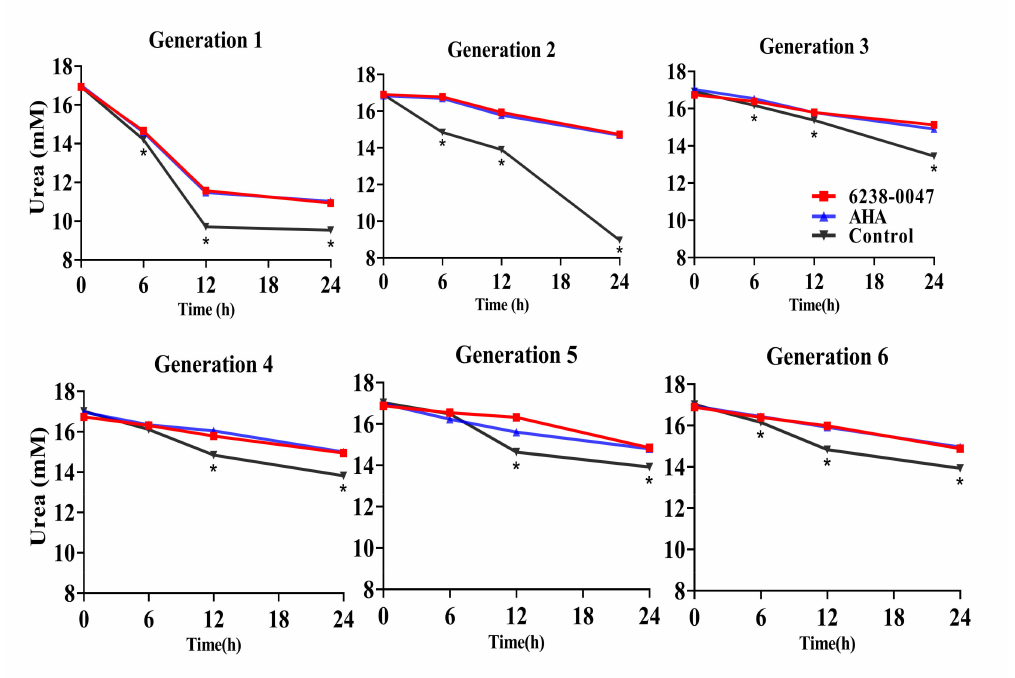
Figure 4. Influence of compound 6238-0047 on the urea in rumen fermentation in vitro. Each point represents the mean of three observations. Acetohydroxamic acid (AHA) acted as a positive control, and the control group only added the methanol solution. Asterisks (*) indicate that the di ff erence between the control group and compound treated group (AHA and 6238-0047) was significant ( p <